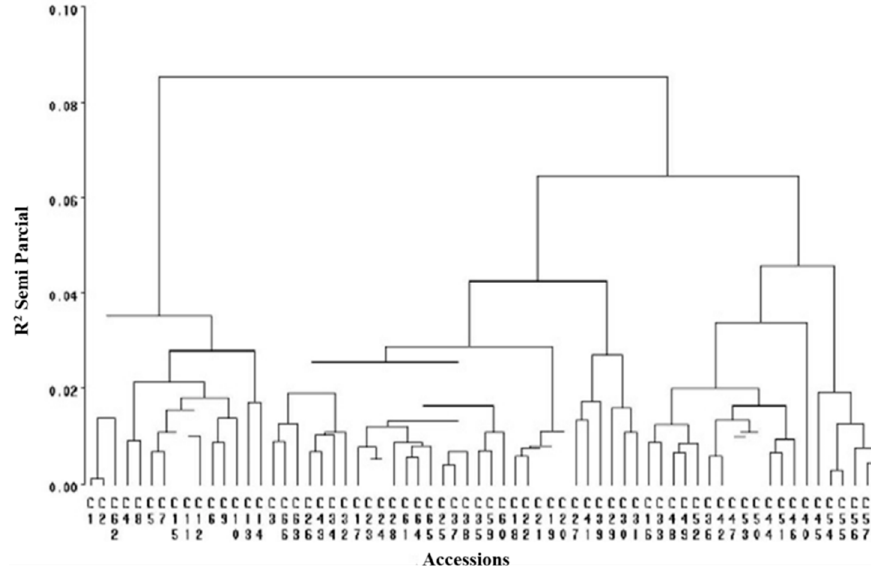
Figure 1. Grouping of Sechium edule accessions evaluated by qualitative characteristics.